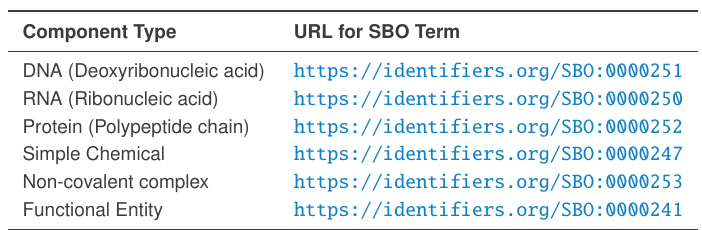
Table 2: Partial list of the most common SBO terms to specify the molecule type using the type property of a Component . Systems of multiple interacting molecules (e.g., a plasmid expressing a protein) should use the functional entity